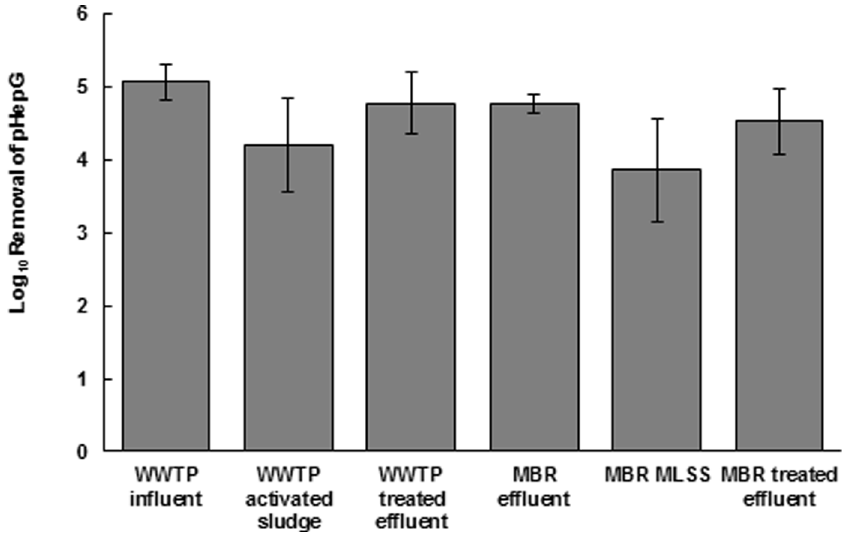
Fig 2. Effects of DNAse digestion on extravirion DNA in various wastewater samples. Values are mean of three replicates. Error bars represent standard deviation. MBR, Membrane bioreactor; MLSS, mixed liquor suspended solids, WWTP, wastewater treatment